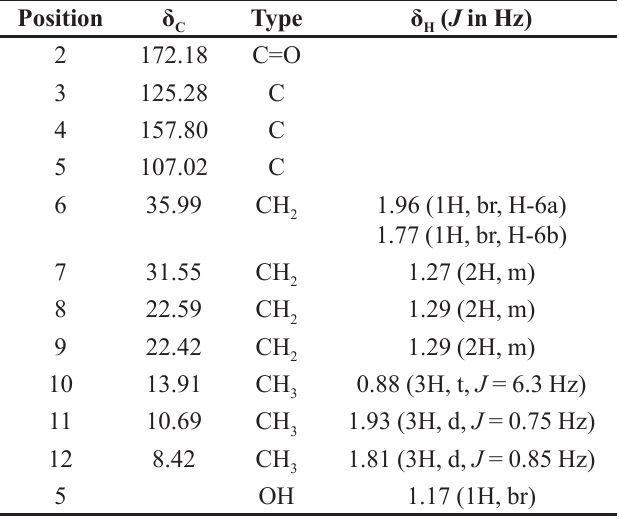
TABLE I - 1 H-NMR and 13 C-NMR spectral data of hydroxydihydrobovolide (500 MHz, CDCl